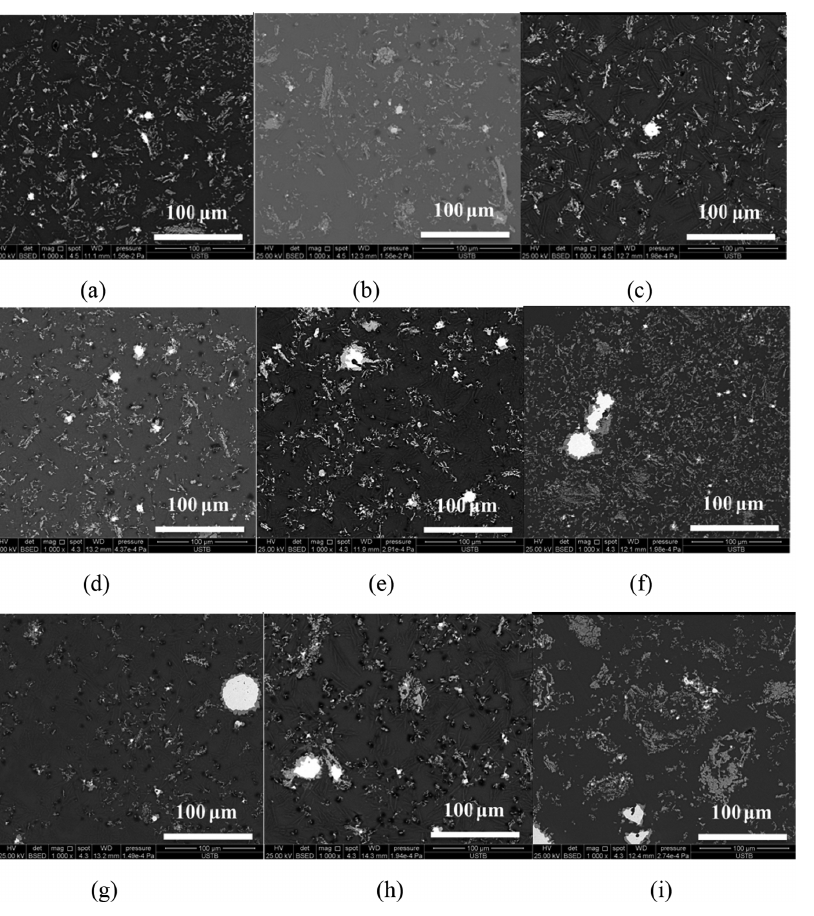
Figure 19: BSED images of the samples reduced with different carbon ratios for different times at 1,873 K: (a) 2 h, 0.7; (b) 2 h, 0.85; (c) 2 h, 1.0; (d) 4 h, 0.7; (e) 4 h, 0.85; (f) 4 h, 1.0; (g) 6 h, 0.7; (h) 6 h, 0.85 and (i) 6 h, 1.0.